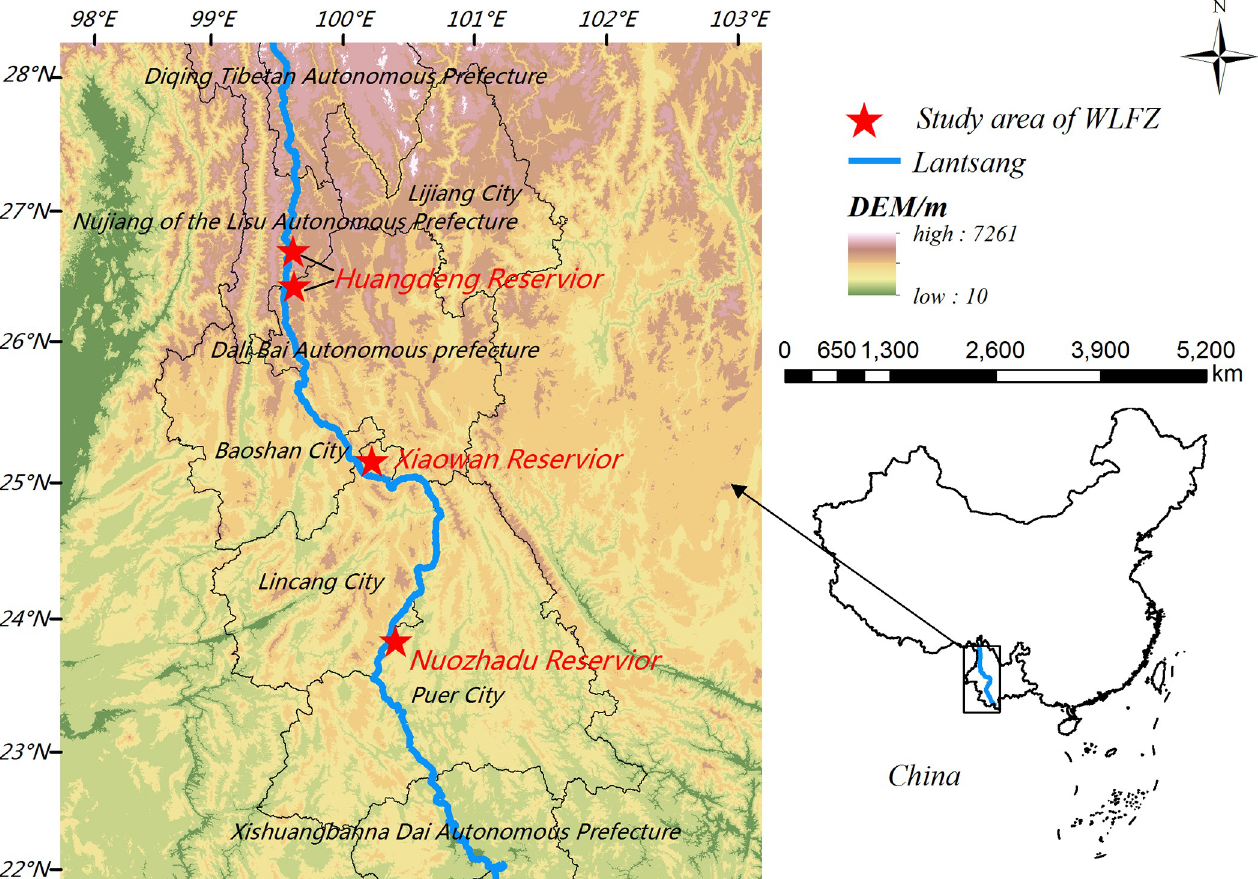
Fig 1. Location of the WLFZ study area (The SRTM 90m DEM map contained is provided by Geospatial Data Cloud site, Computer Network Information Center, Chinese Academy of Sciences. (http://www.gscloud.cn).